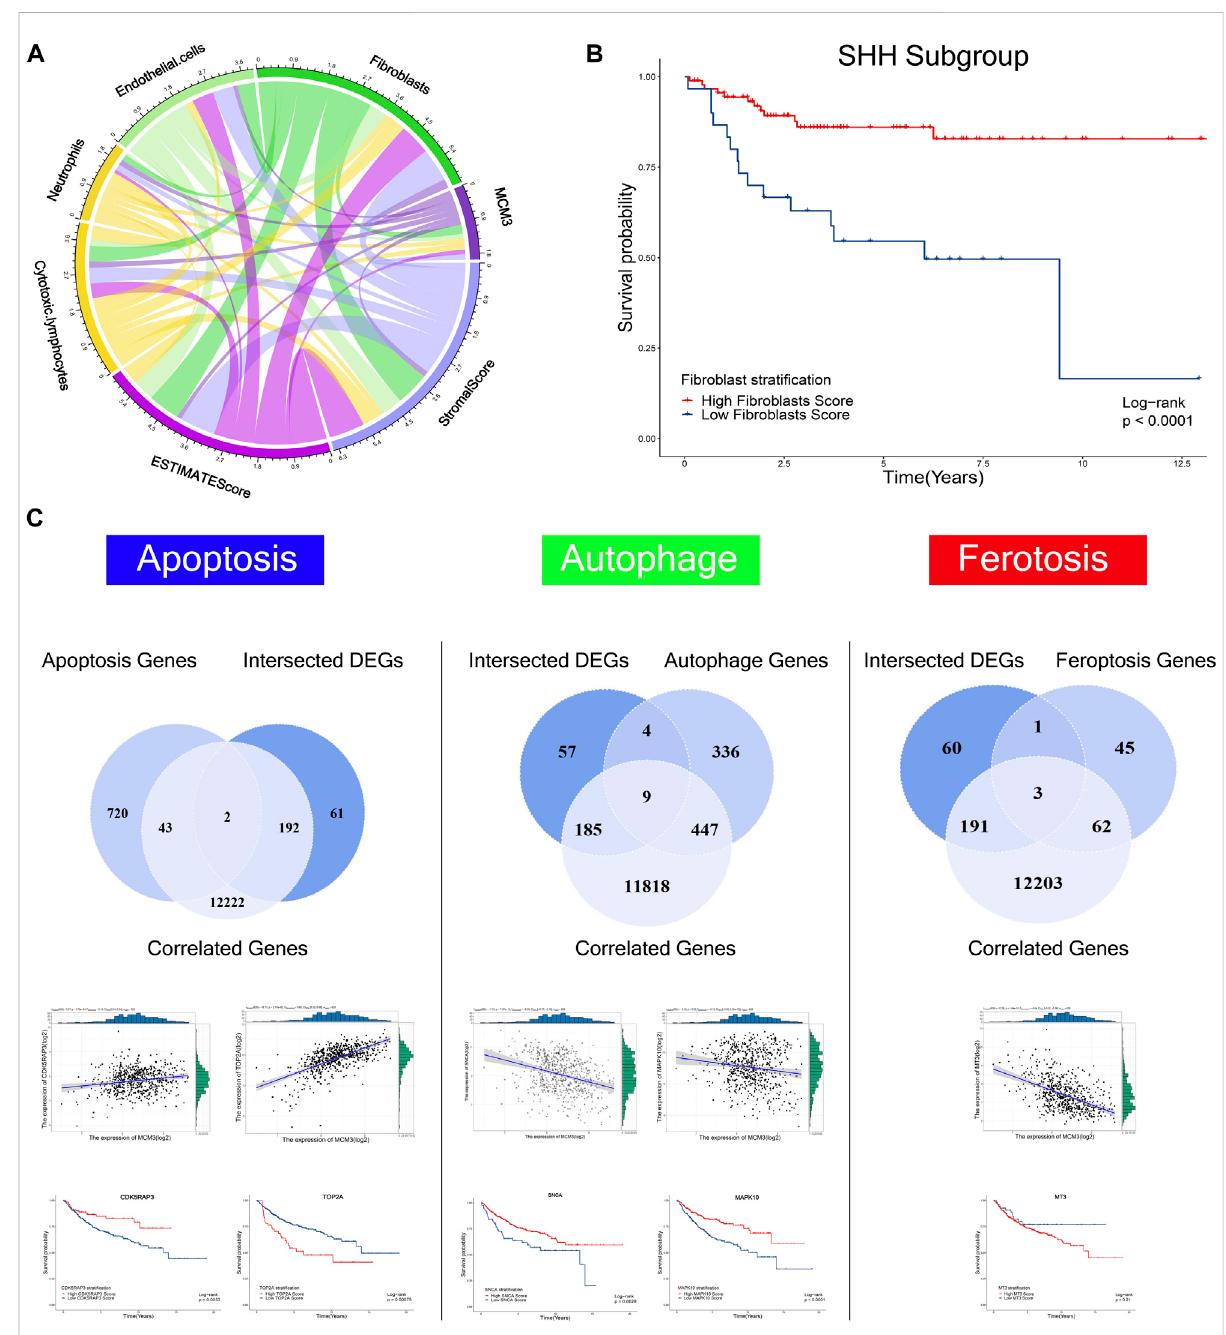
FIGURE 5 Correlationsof MCM3 with fi broblasts, endothelial cells, neutrophils, cytotoxic lymphocytes, estimate score, and stromal score (A) . Association of fi broblasts with OS in the SHH subtype (B) . Kaplan – Meier analysis of genes related to apoptosis, autophagy, and ferroptosis that were correlated with MCM3 and differentially expressed. CDK5RAP3, TOP2A, SNCA, MAPK10 are correlated with MCM3 and associated with OS (C)